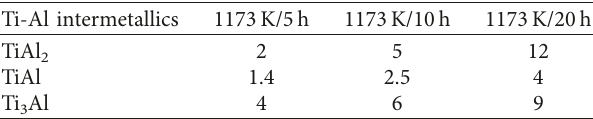
Table 7: Thickness ( μ m) of different Ti-Al Intermetallics layers with 1173K/5h, 1173K/10h, and 1173K/20h.